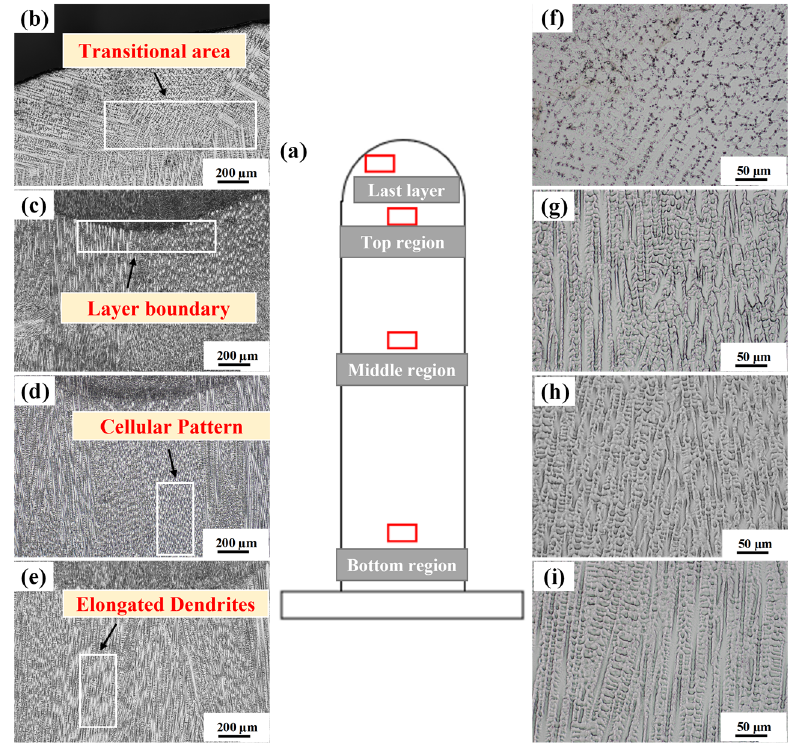
Figure 3. Microstructure morphology in cross-section (y–z plane) of the as-fabricated sample with heat input 276 J/mm. ( a ) Illustration of microstructure observing position; ( b – i ) are representative microstructure at low and high magnifications for different positions: ( b , f ) last layer, ( c , g ) top re- gion, ( d , h ) middle region and ( e , i ) bottom region.